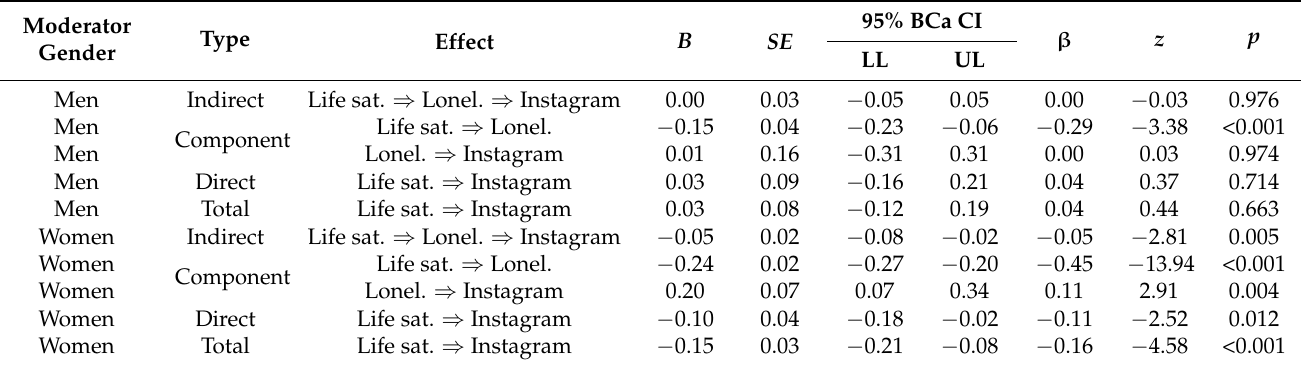
Table 6. The moderating role of gender on the indirect effect of life satisfaction on Instagram addiction via